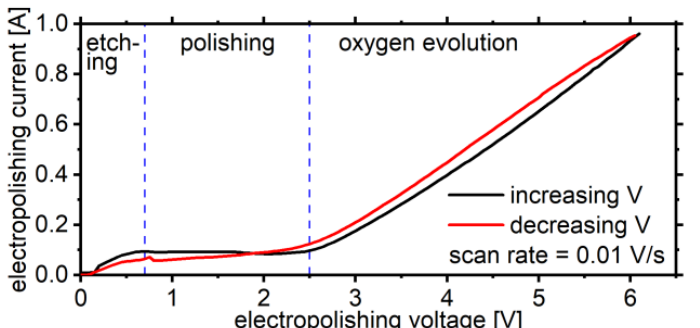
Figure 2. Current-voltage curve of the sample-setup configuration used within this work. Optimal electropolishing results in terms of surface smoothing are achieved in the polishing regime, characterized by a constant current density.